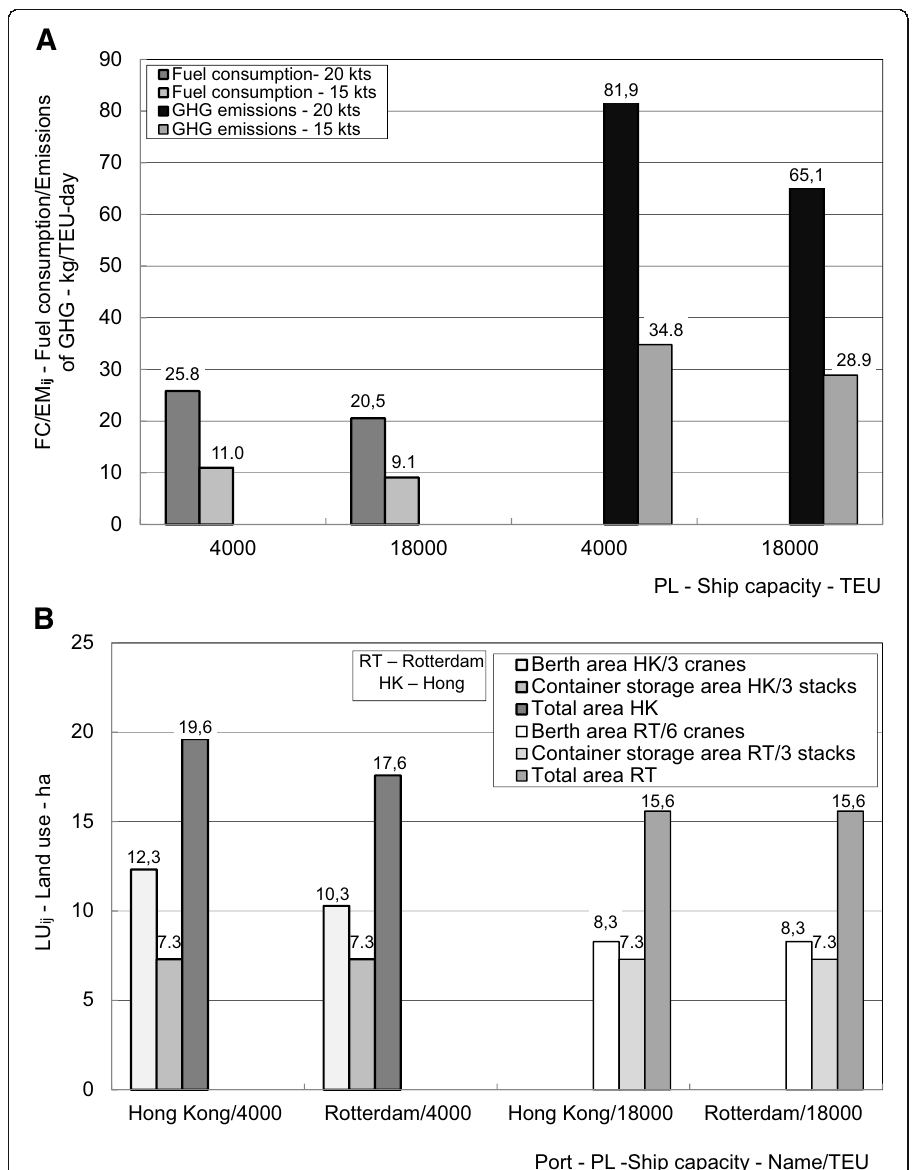
Fig. 11 The indicators of environmental performances of the trunk line/route. a Fuel consumption and emissions of GHG. b) Land